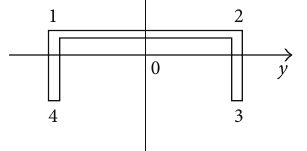
Figure 11: Upper chord. Figure 12: Lower chord.